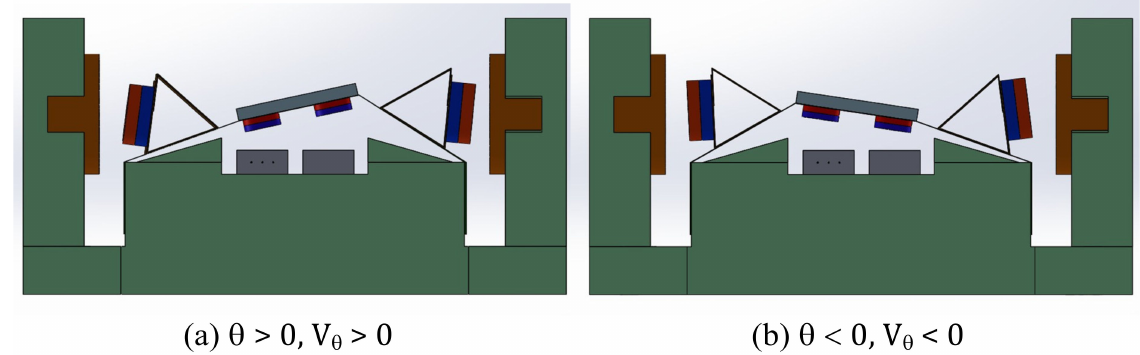
Figure 3. ( a ) Positive and ( b ) negative tilting angles with a corresponding sensor signals.